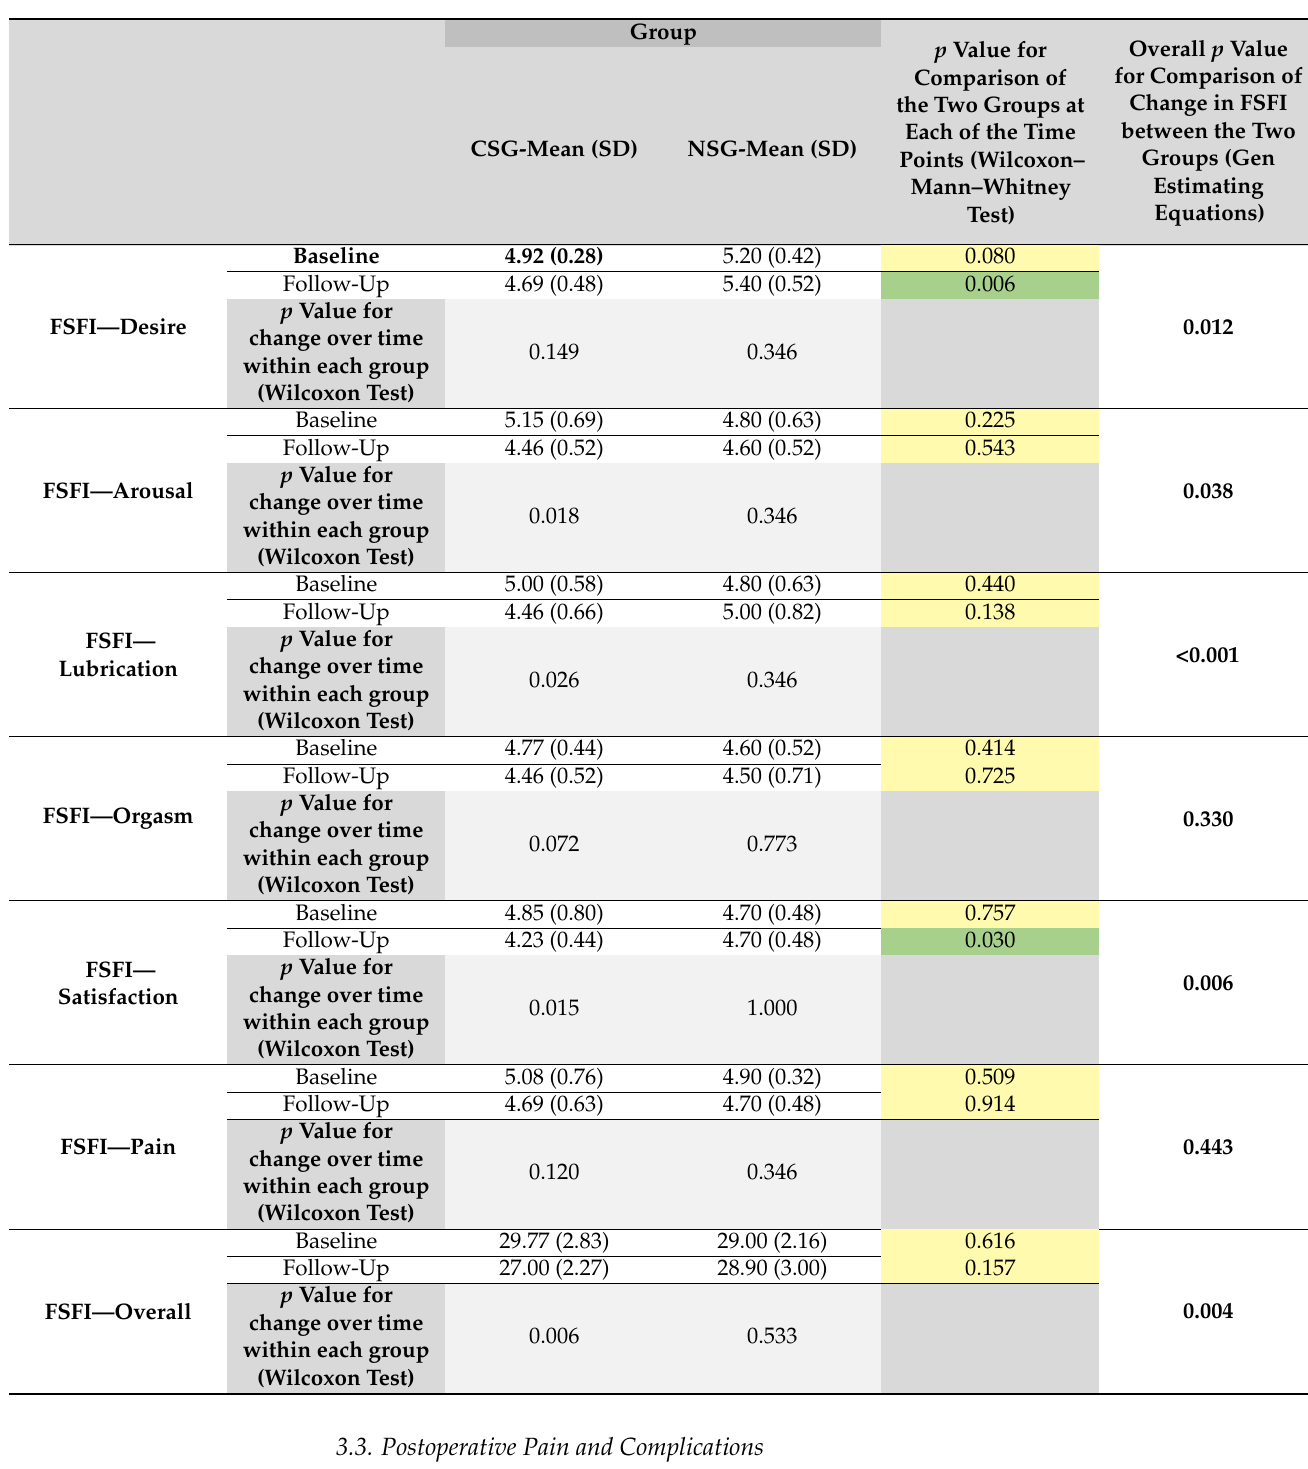
Table 3. Comparison of the two groups in terms of change in FSFI (n =